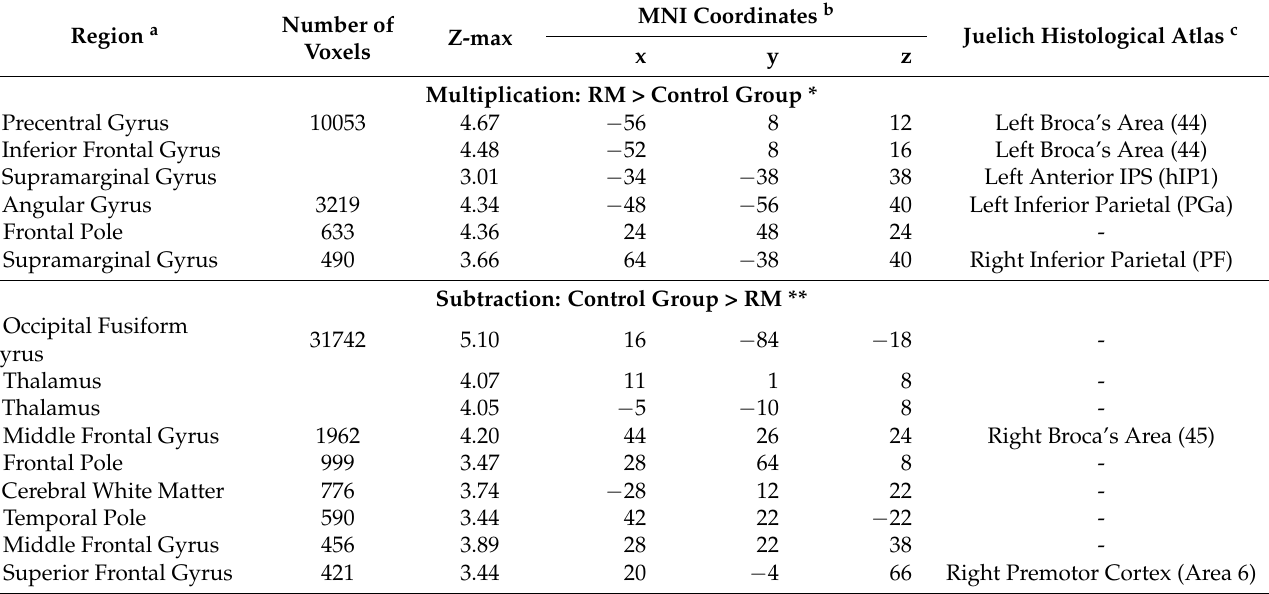
Table 4. Brain activations by contrast for the comparison of RM with the control group.